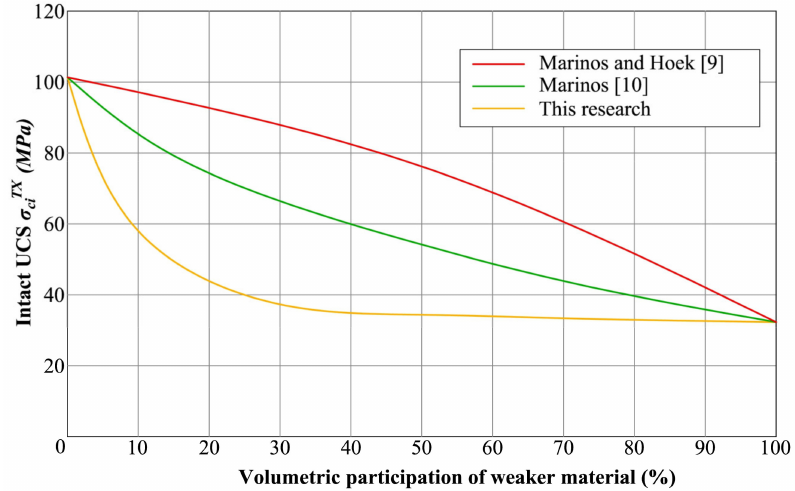
Figure 16. Comparison of the intact rock material UCS σ ciTX .